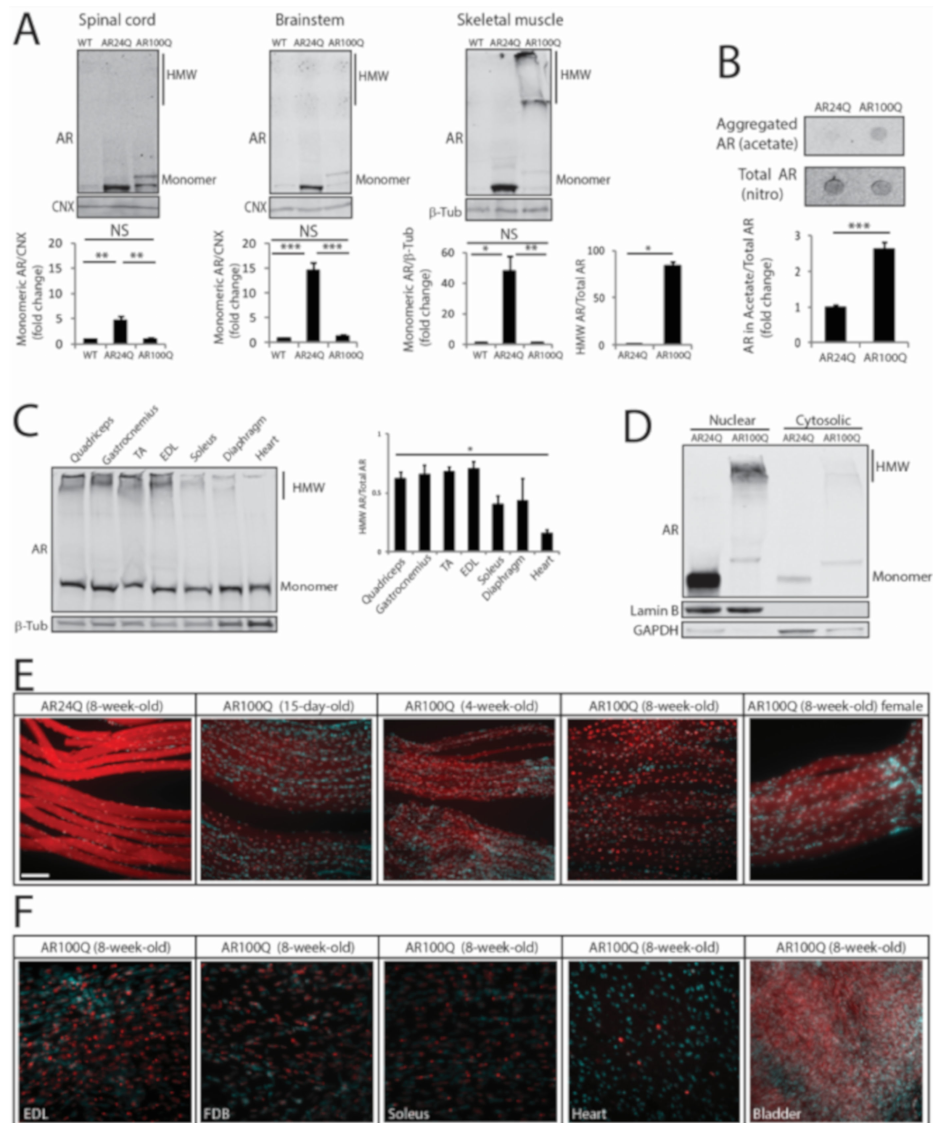
Figure 6. PolyQ-expanded AR forms 2% SDS-resistant aggregates and inclusion bodies in skeletal muscle. ( A ) Western blotting analysis of AR in 8-week-old WT, AR24Q and AR100Q male mice ( n = 3). Quantification is shown at the bottom of each panel. ( B ) Filter retardation assay of total protein extracts from quadriceps muscle of 8-week-old AR24Q and AR100Q male mice ( n = 3). ( C ) Western blotting analysis of AR in the indicated tissues from 4-week-old AR100Q male mice ( n = 3). ( D ) Western blotting analysis of nuclear and cytosolic fractions from quadriceps muscle of 8-week-old AR24Q and AR100Q male mice ( n = 2). ( E , F ) Immunofluorescence analysis of AR subcellular localization in intact fibers from gastrocnemius muscle ( E ) and the indicated muscles ( F ) of AR24Q and AR100Q male and female (where indicated) mice. Bar, 100 microns. In ( A – D ) AR was detected with a specific antibody and calnexin (CNX) and beta-tubulin ( β -Tub) were used as loading controls. HMW, high-molecular-weight species. In ( D ) lamin B and GAPDH were used as loading controls of nuclear and cytosolic fractions. Graphs, mean ± sem. Statistical testing: Student’s t-test in ( A , panel HMW species) and ( B ); one-way ANOVA followed by Newman-Keuls post-hoc test ( C ); * p < 0.05, ** p < 0.01, *** p < 0.001. NS, non-significant. In ( E , F ) AR (red) was detected with a specific antibody and nuclei with DAPI (blue) in intact fibers. Shown are representative images of at least 3